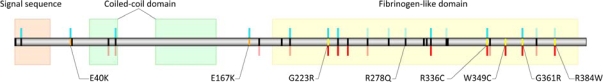
A schematic representation of ANGPTL4 coding region. The locations of variant sites are colored according to their affect on protein functionality as previously described [4]. Yellow sites prevent protein secretion, orange sites cause a non-functional protein to be secreted, and black sites were not tested in vitro. Amino acid sites identified by PolyPhen as “possibly damaging” are indicated in light red; “probably damaging” sites are shown in dark red. Radically changing (categories 6, 7, and 8) amino acid sites identified by TreeSAAP are shown in blue, with category 8 sites in dark blue.